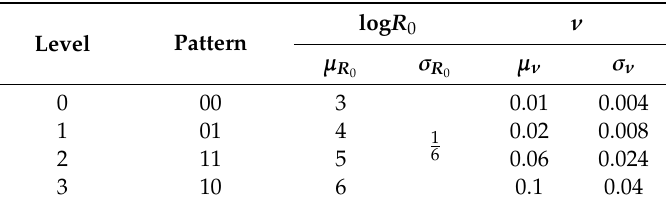
Table 1. Resistance drift parameters of 4LC PCM.